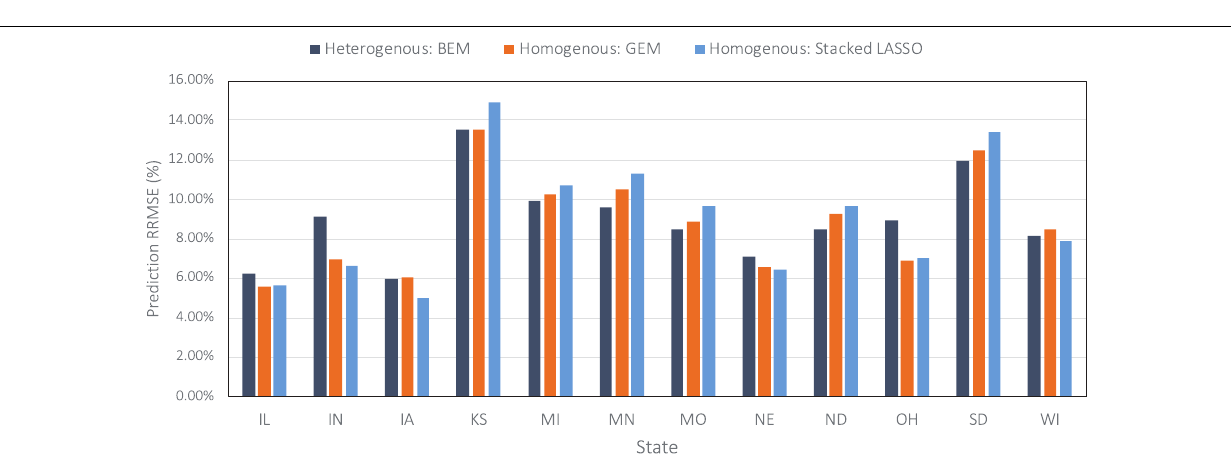
To achieve the stratified splits, we binned the observations in corresponding yield values.